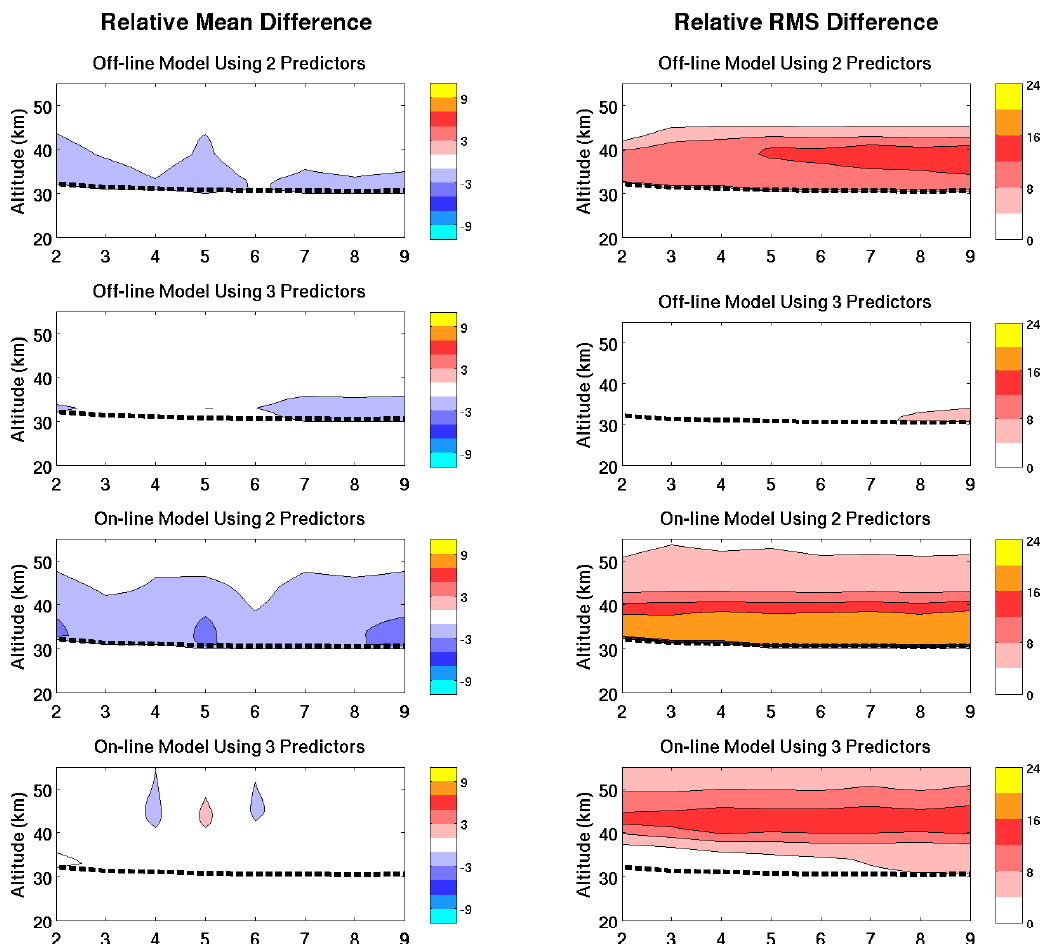
Fig. 7. Errors in percents of the statistical model when used off-line or on-line to predict the ozone perturbation due to solar variability in an independent set of experiments, as a function of simulation day (horizontal axis) and altitude (vertical axis). The left column indicates the relative bias in the statistical model, calculated as the mean difference between solar variability simulations with the statistical model used off/on-line and the control experiment, divided by root mean square difference between the control and the solar average experiments. The right column indicates the relative error of the statistical model, calculated as the root mean square difference between solar variability simulations with the statistical model used off/on-line and the control experiment, divided by root mean square difference between the control and the solar average experiments. Below the thick black dashed line lies the region where no calculation is made because the denominator is smaller than one thousands of the solar average ozone